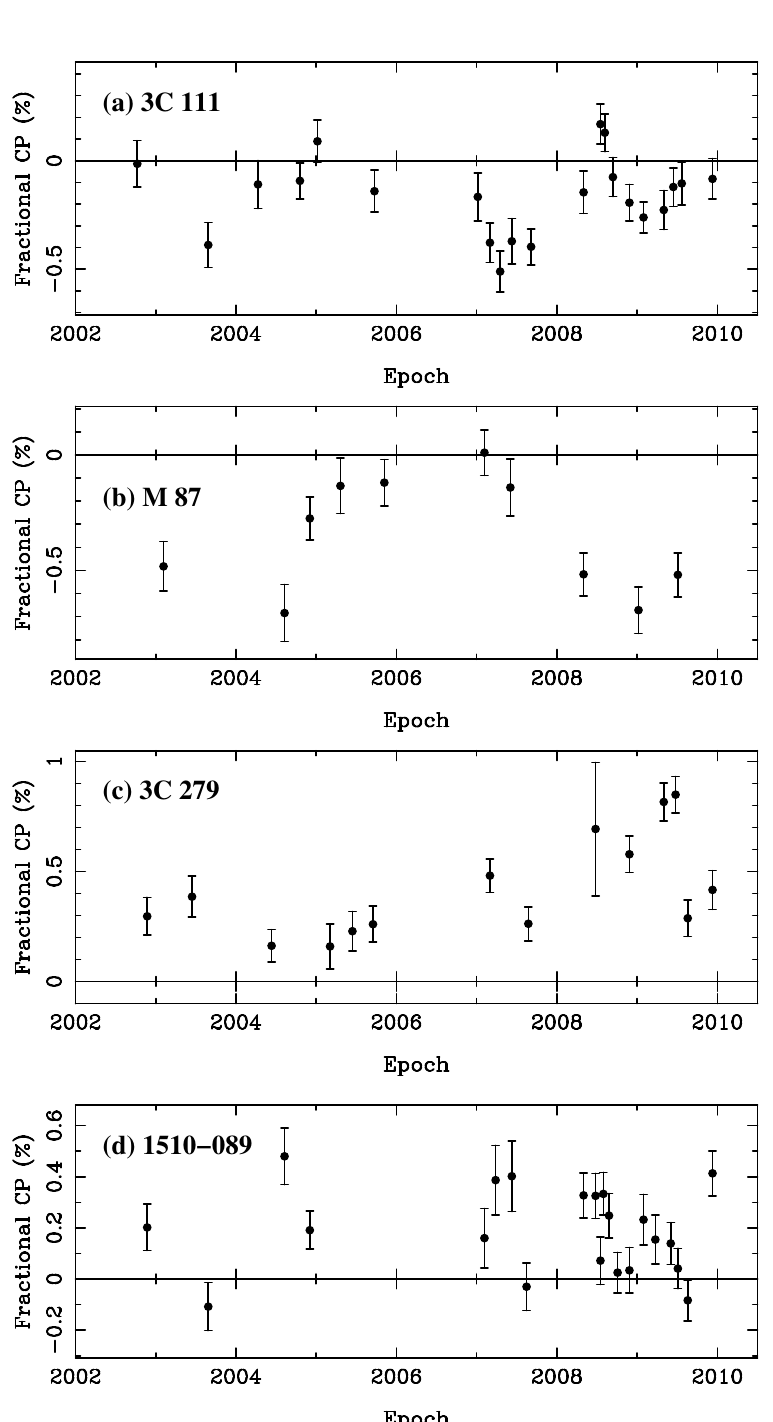
Figure 2. Panels (a–d) show fractional circular polarization as a function of epoch in the jet cores of several Active Galactic Nuclei (AGN) with repeated detections of strong circular polarization. As noted in the text, most sources in the our program do not show strong circular polarization, and smaller subset shows repeated detections of strong circular polarization. Of the 39 sources with multi-epoch 3 σ detections of circular polarization spanning at least a year, 35 show a preferred sign, as illustrated here. Sign